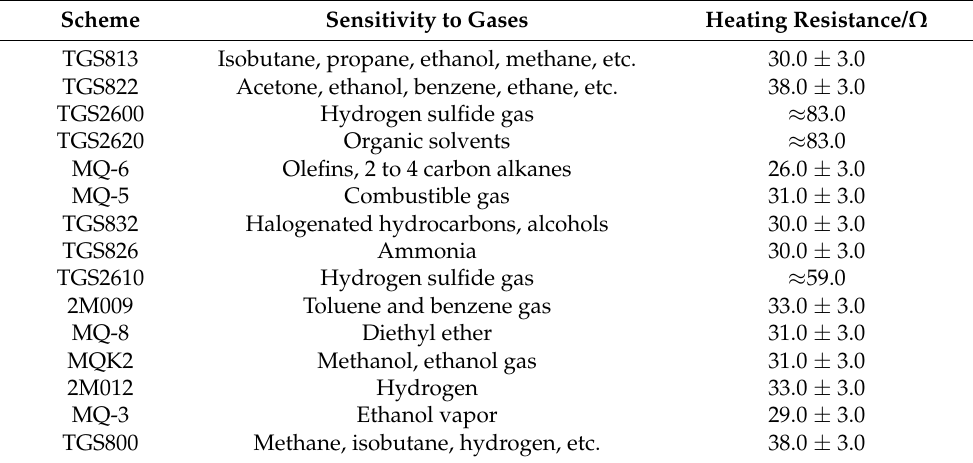
Figure 1. Response curves of sensors to West Lake Longjing tea. The dotted box contains stable data. Table 2. Detailed information of preliminary